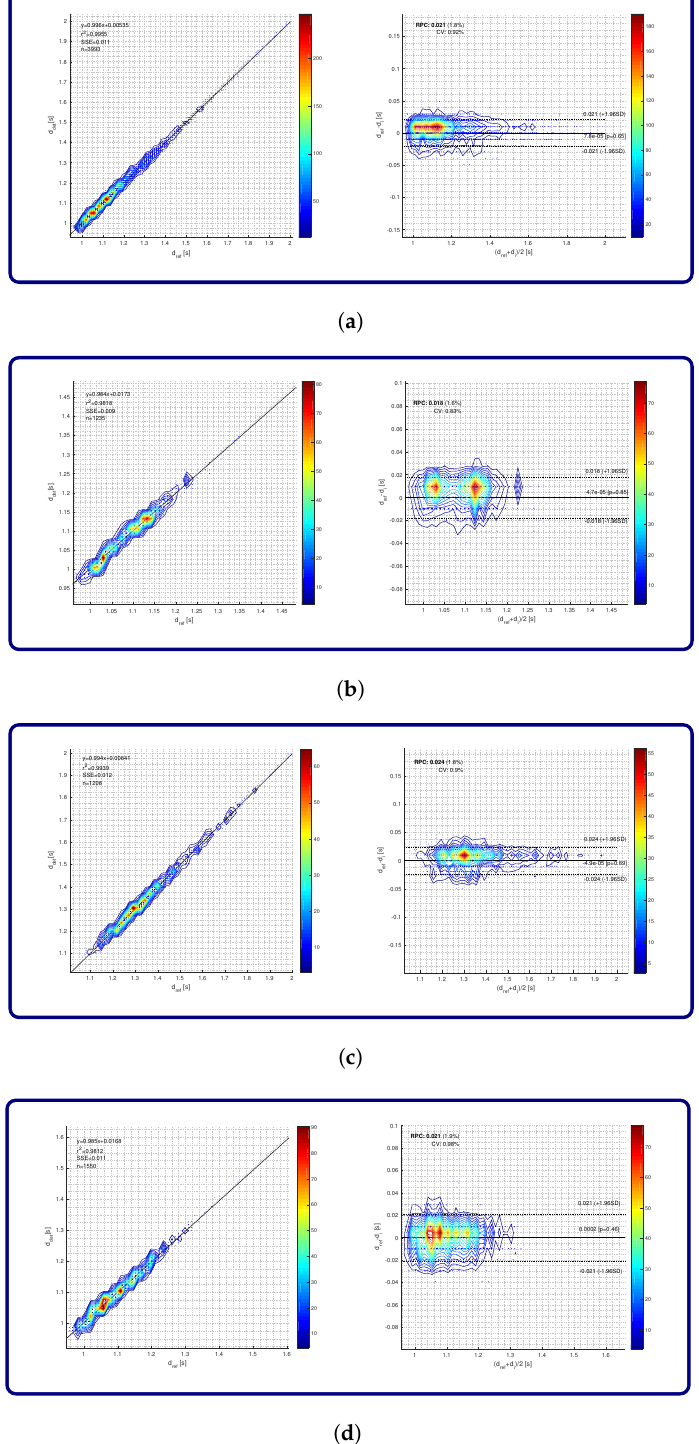
Figure 9. Regression analysis and Bland–Altman plots for stride detection accuracy on the eGait dataset over different cohorts: ( a ) overall; ( b ) control subjects; ( c ) geriatric subjects; ( d ) PD patients. Colour map represents the number of